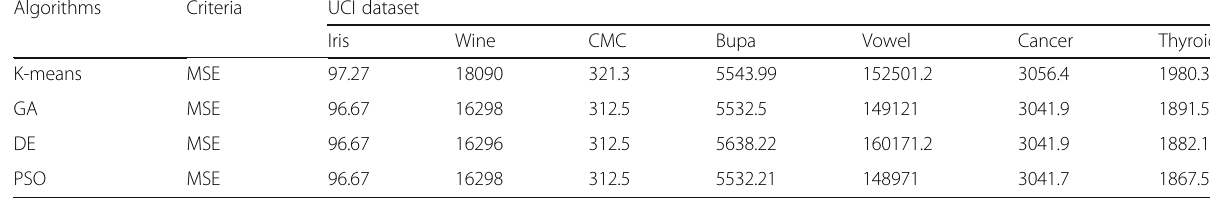
Table 1 Comparison of four proposed algorithms on the UCI dataset